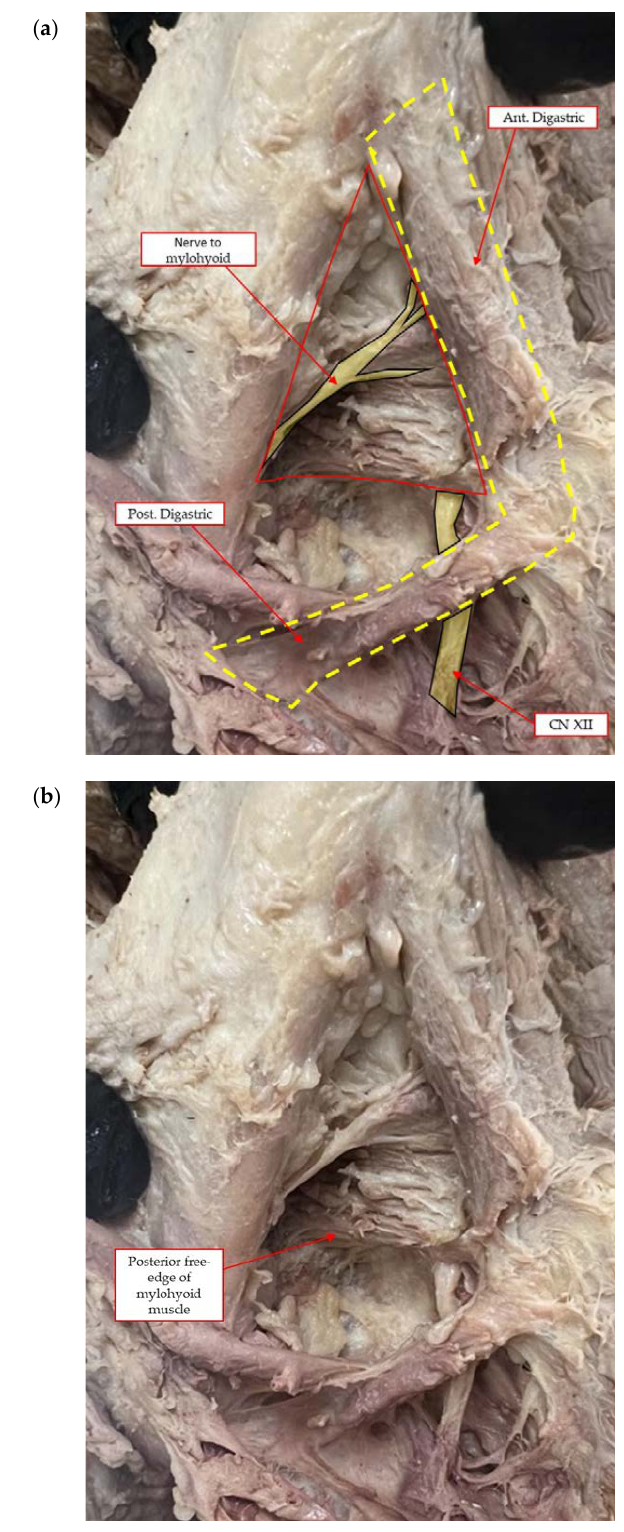
Figure 3. ( a , b ) In a human cadaver model, the mylohyoid muscle attachment to the mandible is more apically located in the premolar zone as compared to the attachment at the molar zone. Should the surgical dissection during MMR, extend deeper into the mylohyoid muscle fiber attachment, the vital structures as described above are positioned apical and medial to the mylohyoid